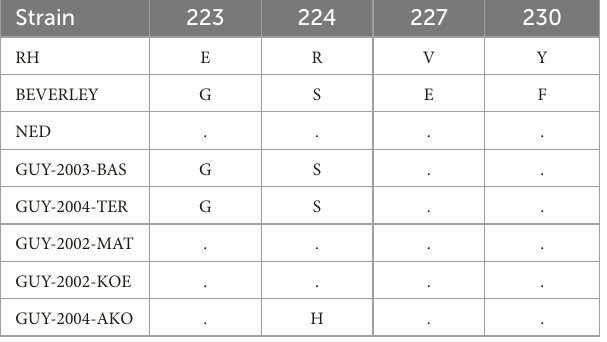
TABLE 4 C-terminal amino acid polymorphisms for GRA6 marker for genotype I (RH), genotype II (Beverley), genotype III (NED), and five non-archetypal strains